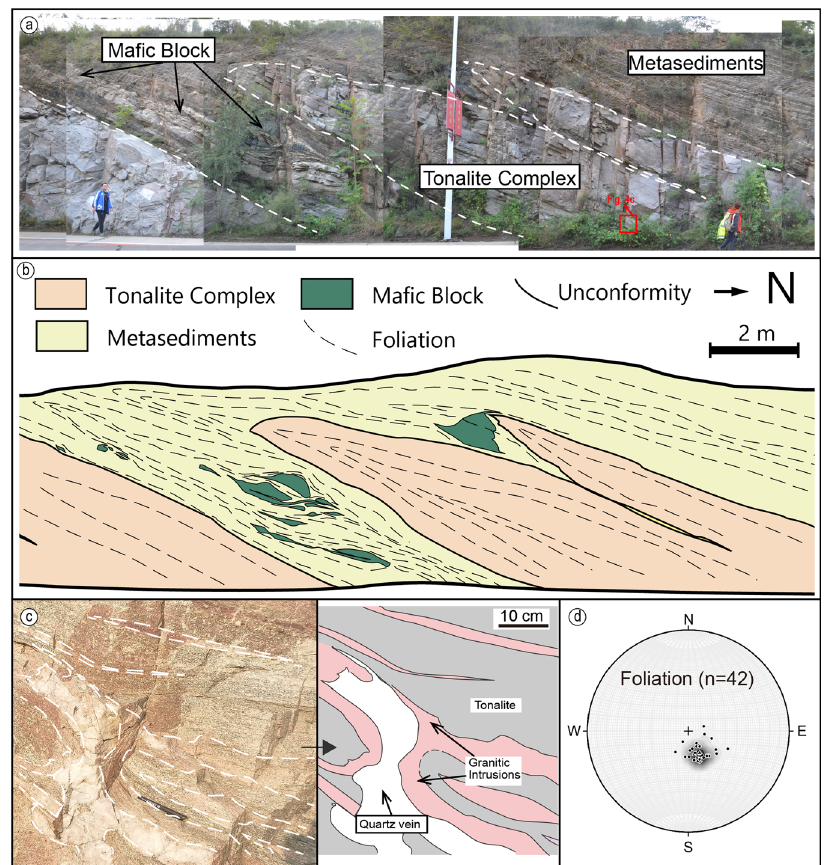
Fig.4|Pro fi lemappingofunconformity. Thelocationofthisoutcropisshownin Fig. 1d. a Field photos of the unconformity section. b Structural pro fi le mapping, showing the structural features of the contact. c Photo and sketch showing the